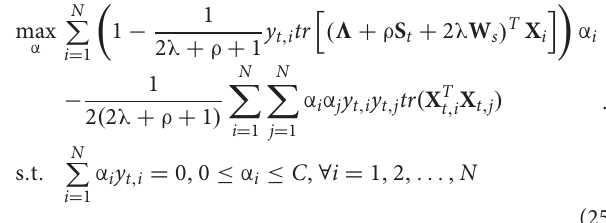
Algorithm 1: The learning procedure for